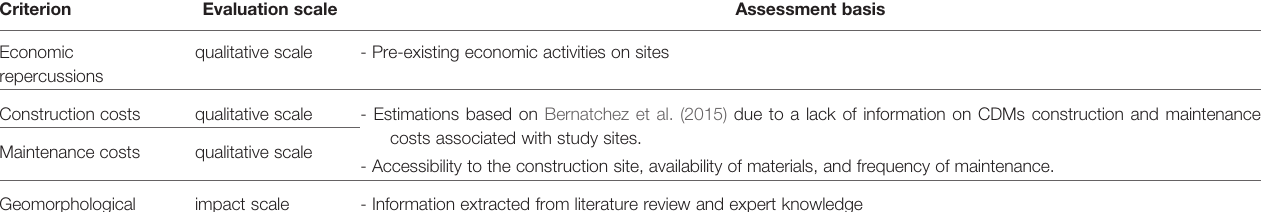
TABLE 5 | Assessment basis and evaluation scale for the evaluation of CDMs in relation to each